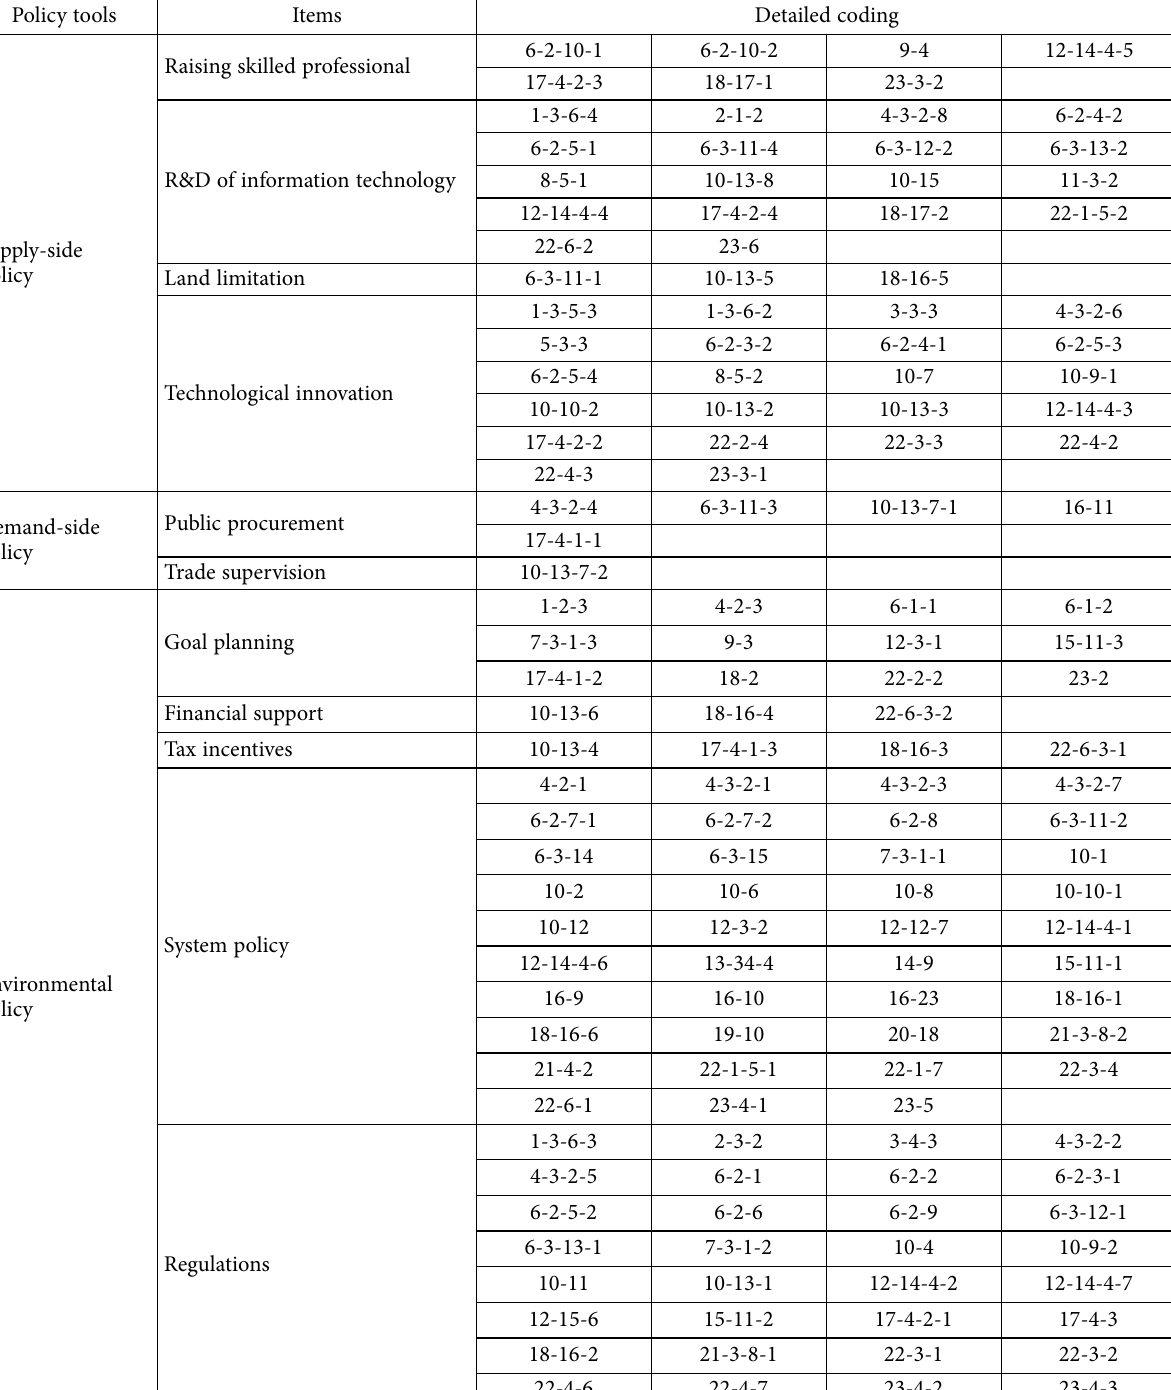
Table 3. Policy instruments related to